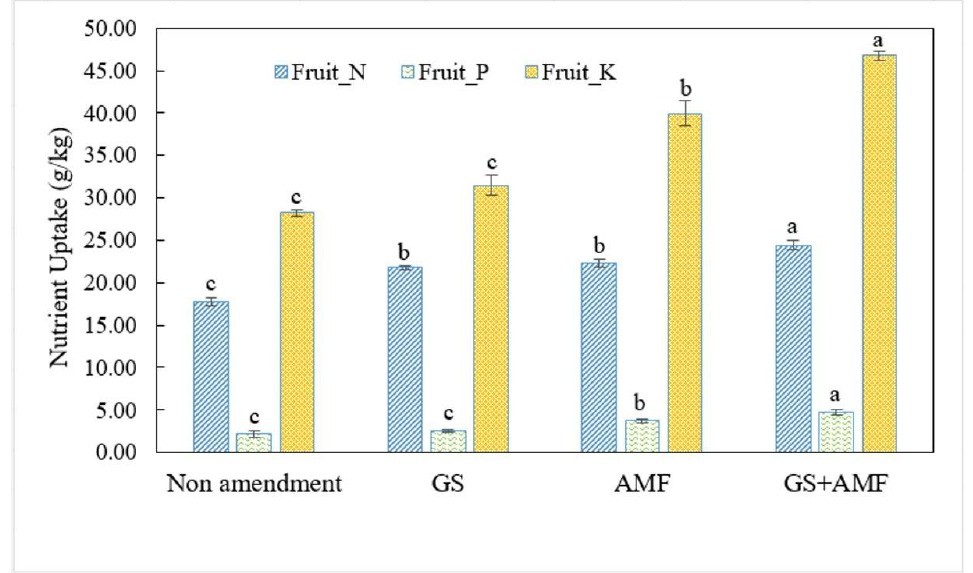
Figure 2. The nutrient uptake analysis in the final harvest of cucumber fruits examined during the spring cultivation of 2018. Different letters indicate the significant differences ( p < 0.05) by means comparisons (means ± SE, n = 3). Table 4. The seasonal greenhouse cucumber yield (g/plant) in two years under plastic greenhouse vegetable cultivation (PGVC) amended and non-amended treatments.